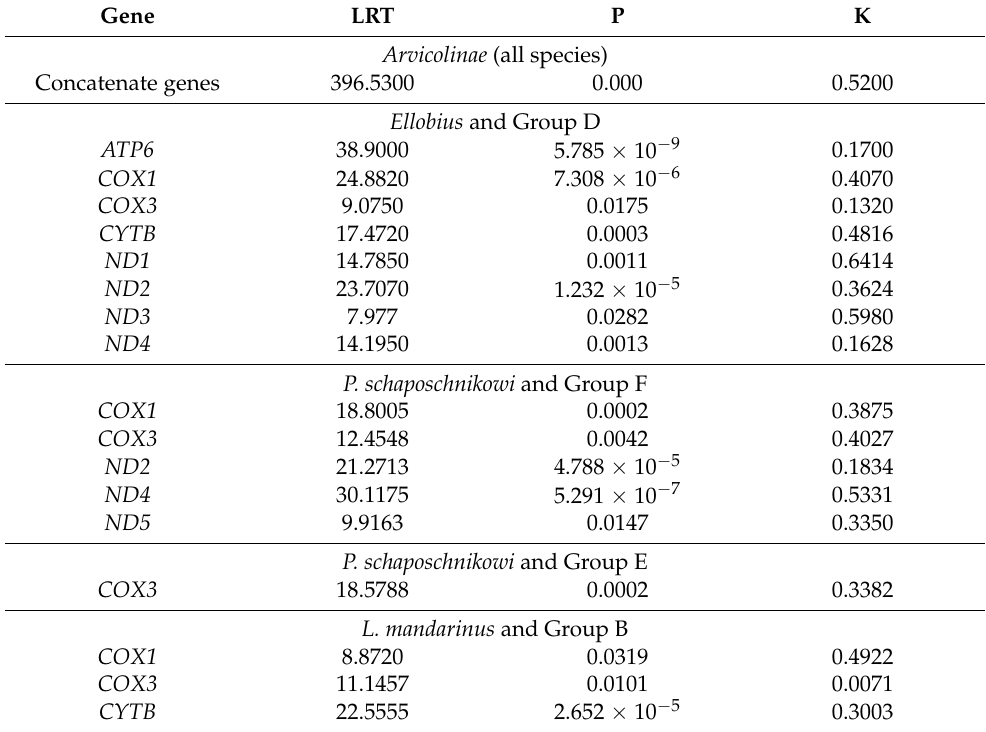
Table 3. Estimation of natural selection intensity using the RELAX approach. LRT-likelihood ratio test, P-adjusted p -value, K-selection intensity parameter. Only significant results are given in this table, all values can be found in Supplementary Table